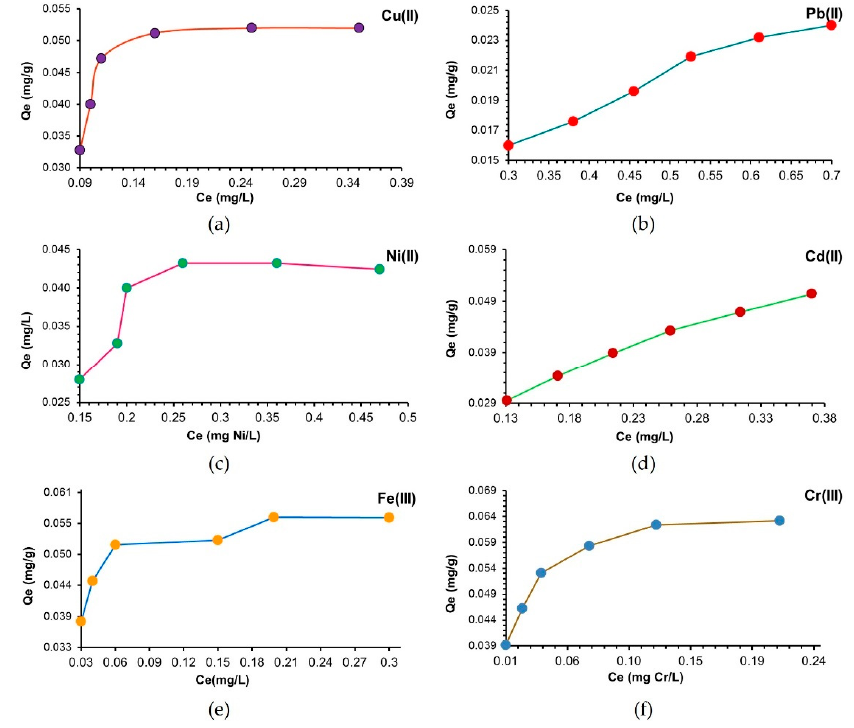
Figure 3. Effect of M X+ initial concentration on the adsorption capacity of MS. Experimental conditions: Ci = 0.5–1 mg/L M X+ , contact time 60 min, 175 rpm (25 ± 2°C), 0.5 g of MS, pH = 4.2.